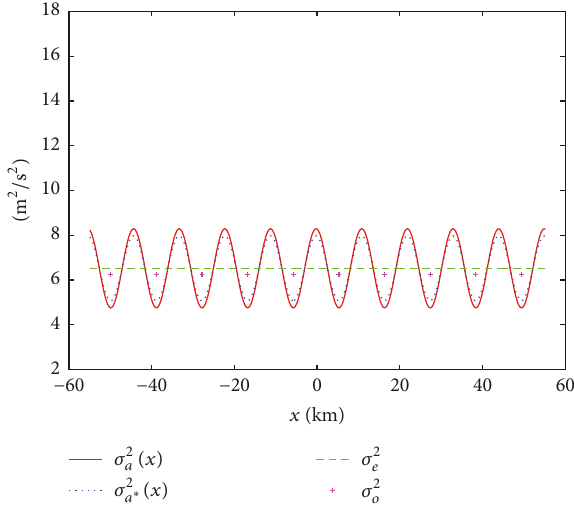
Figure 1: Benchmark analysis error variance 𝜎 2 𝑎 (𝑥) plotted by red solid curve and estimated analysis error variance 𝜎 2 𝑎 ∗ (𝑥) in (7) plotted by blue dotted curve. The green dashed line shows the constant analysis error variance 𝜎 2 𝑒 estimated from the spectral formulation. The purple + signs show the observation error variance ( 𝜎 2 𝑜 = 2.5 2 m 2 s −2 ) at the locations of 𝑀 (=10) uniformly distributed coarse-resolution observations with Δ𝑥 co = 𝐷/𝑀 (=11.04km). The backgrounderrorcovariance 𝜎 2 𝑏 𝐶 𝑏 (𝑥) hasthedouble-Gaussianform with 𝐶 𝑏 (𝑥) = 0.6 exp (−𝑥 2 /2𝐿 2 ) + 0.4 exp (−2𝑥 2 /𝐿 2 ) , 𝜎 2 𝑏 = 5 2 m 2 s −2 and 𝐿 = 10 km. The analysis domain length is 𝐷 = 𝑁Δ𝑥 = 110.4 km with 𝑁 = 260 and Δ𝑥 = 0.24 km, and the number of coarse- resolution observations is 𝑀 = 10